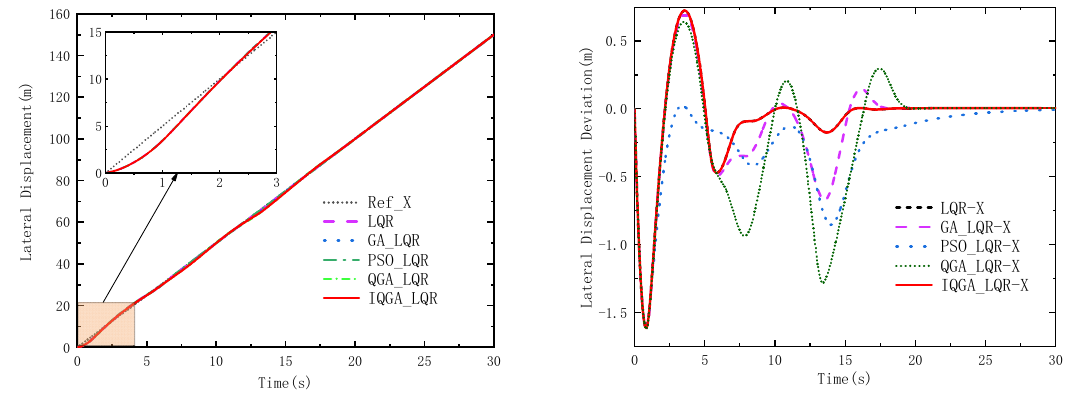
Figure 12. Lateral displacement and deviation.